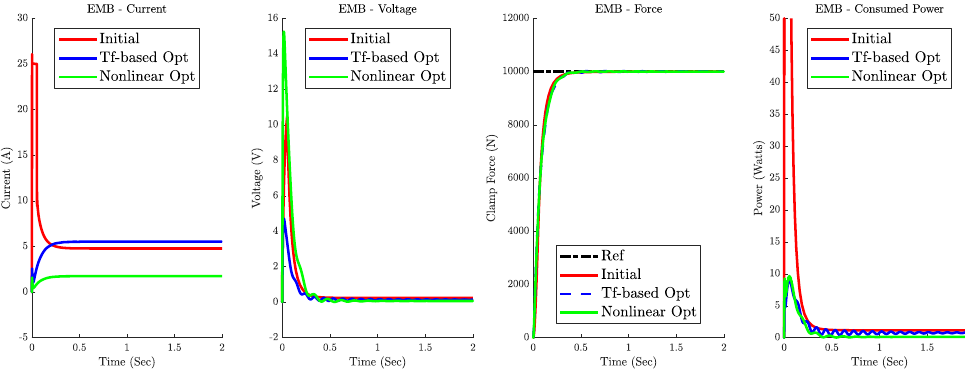
Figure 9. Comparison of the initial parameter sets vs. optimized in an EMB for a 10 kN step input. The clamp force plot for the initial parameter setting was consistent with Line et al. [6]. The optimized results are the novelty of this